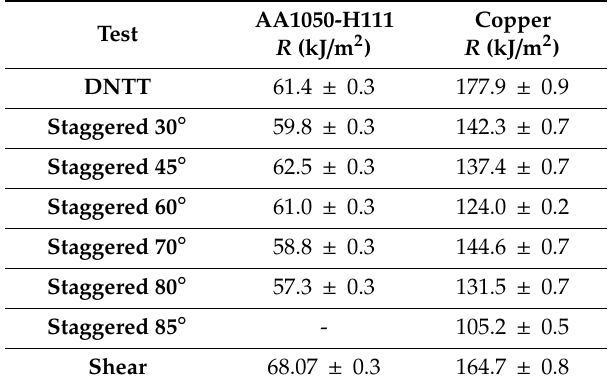
Table 6. Fracture toughness of the aluminium AA1050-H111 and copper sheets with 1 mm thickness obtained from di ff erent